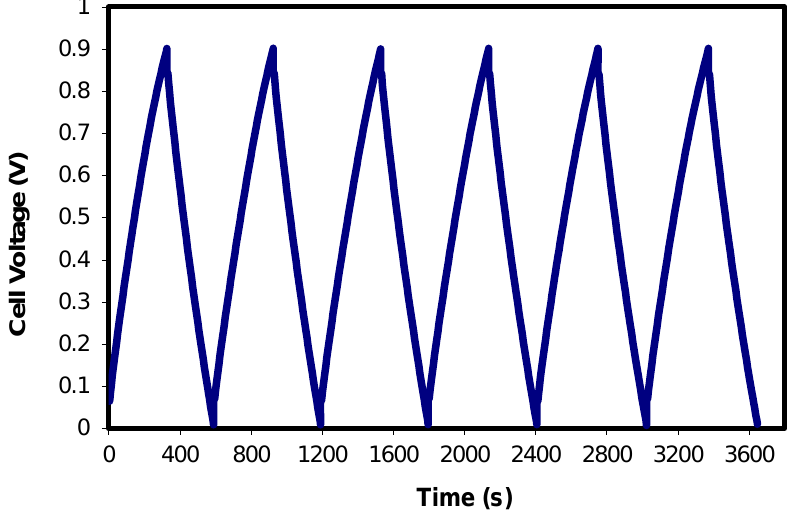
Figure 6. Charge–discharge profiles of EDLC at selected cycles.